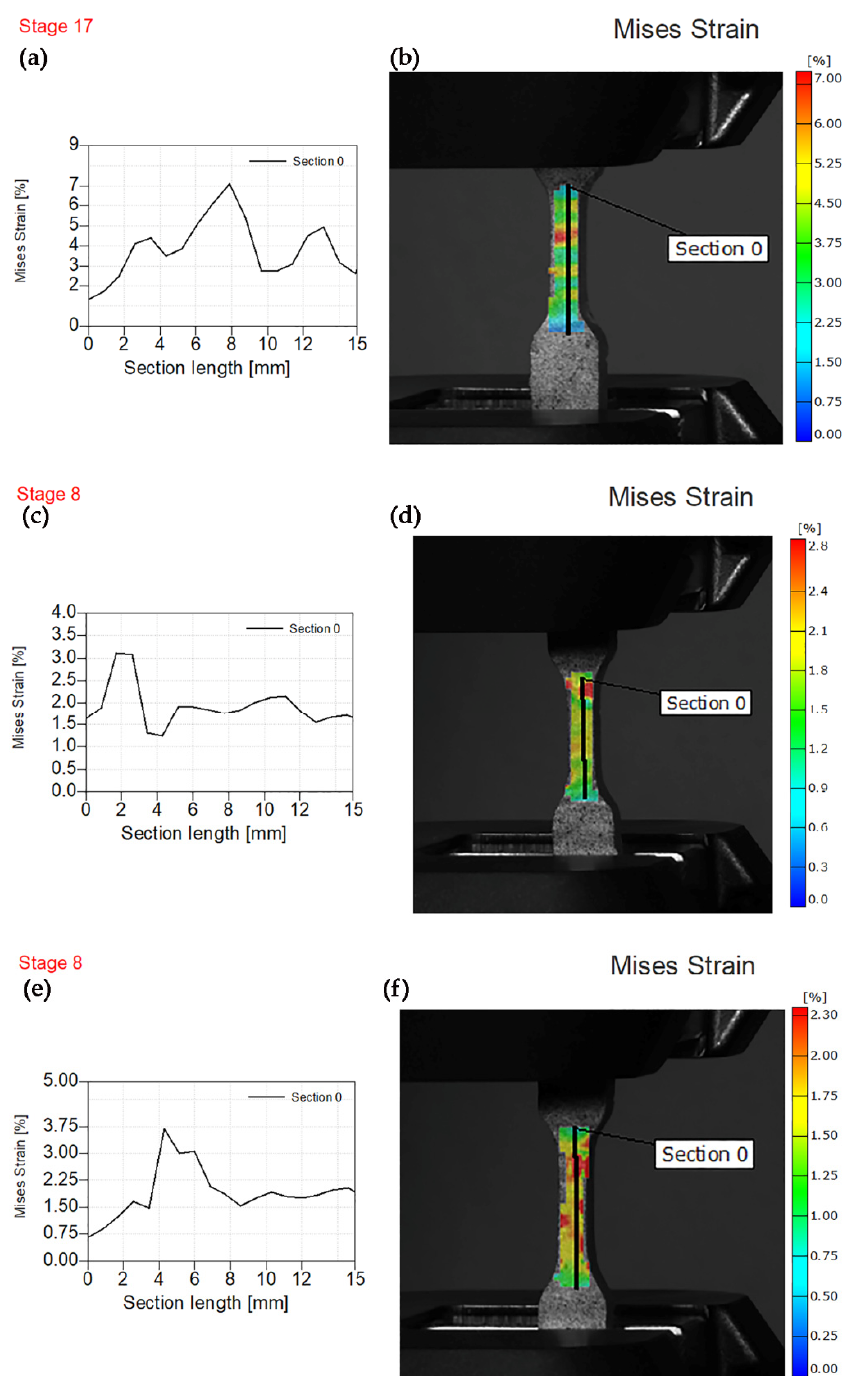
Figure 11. Experimental von Mises strain before fracture. ( a ) Von Mises strain—section length for PE/1TS. ( b ) Sample image PE/1TS with the overlaying von Mises strain field. ( c ) Von Mises strain—section length for PE/2TS. ( d ) Sample image PE/2TS with the overlaying von Mises strain field. ( e ) Von Mises strain—section length for PE/3TS. ( f ) Sample image PE/3TS with the overlaying von Mises strain